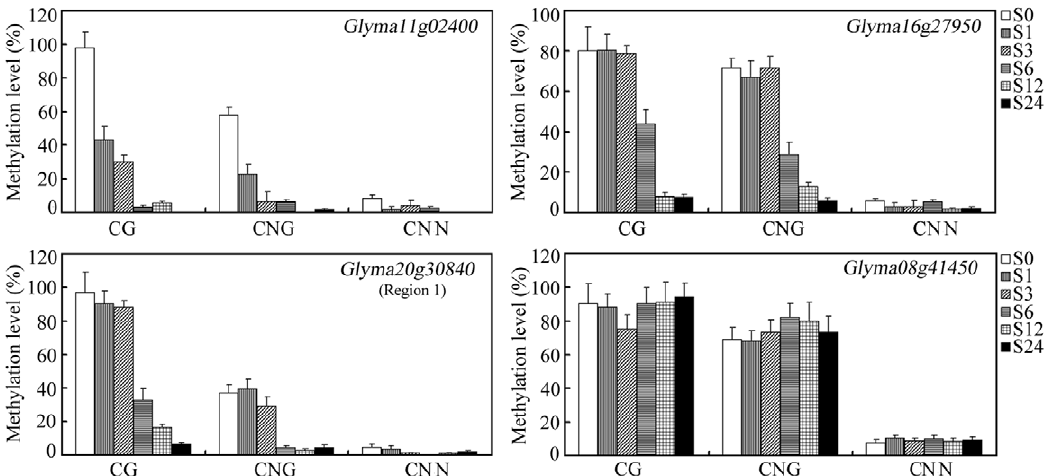
Figure 4. DNA methylation patterns in Glyma11g02400 , Glyma16g27950 , Glyma08g41450 and Glyma20g30840 in non-stressed (S0) and salinity-stressed (S1 S24) seedlings. The left axis shows the percentage of methylated cytosines at each site (present as CG, CNG and CNN). The data represent the mean of three biological replicates. Error bars represent standard errors.